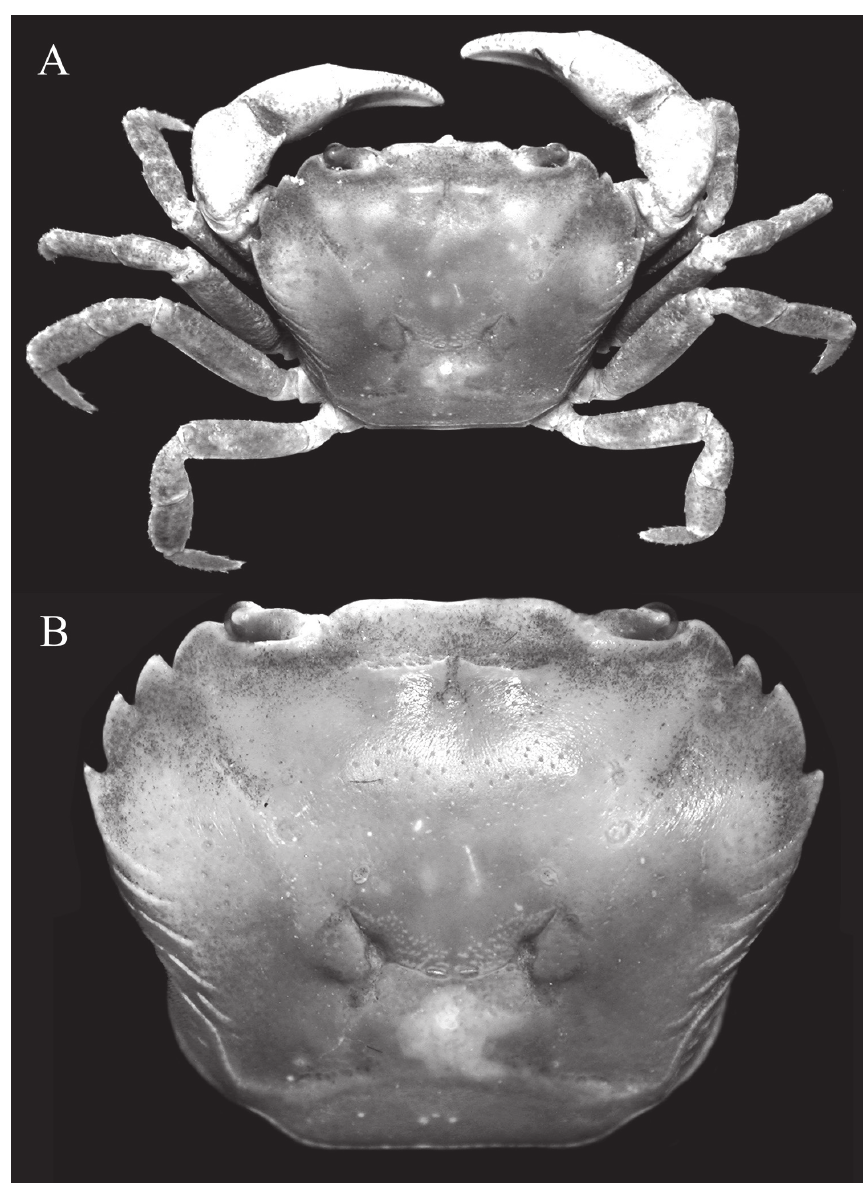
Figure 1. Salangathelphusa peractio sp. n., holotype: male (22.3 × 17.7 mm) (ZRC 2017.208), Lang- kawi. A overall habitus B dorsal view of